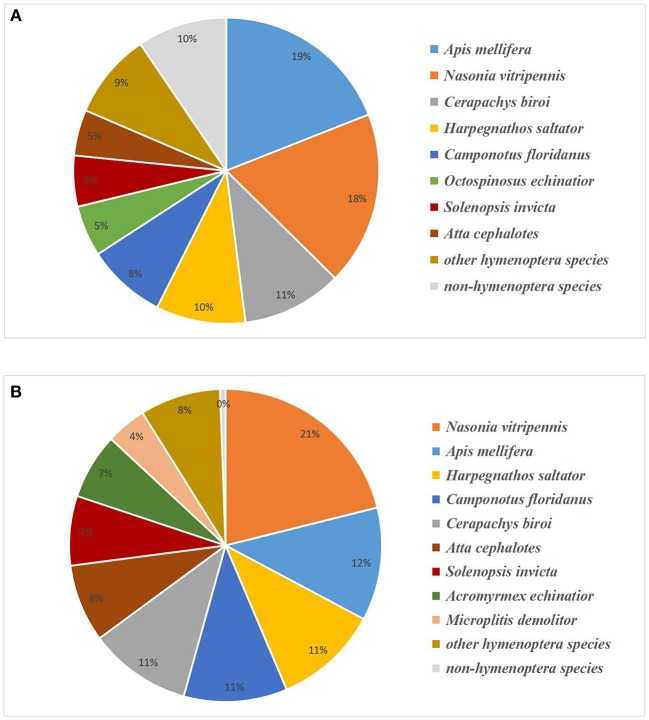
Species distribution of BLASTX hits of experimental unigenes (A) and proteins (B). Unigenes or proteins homologous to Hymenoptera were assumed to belong to A. gifuensis.